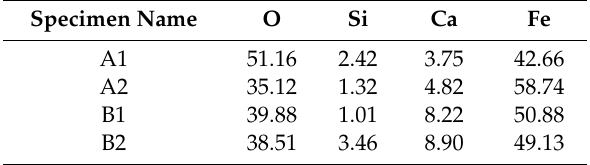
Table 3. Elemental composition of specimens measured by EDS (%).